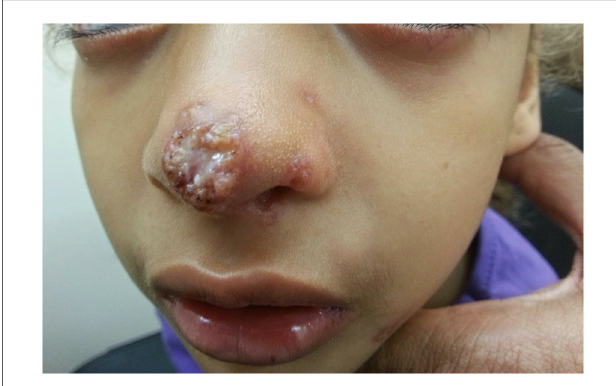
FIGURE 4 An erythematous plaque with a central erosion, circinate-elevated border, overlying pustules, and purulent discharge on the tip of the nose of a 10.5- year-old girl with AT. Small satellite papules were also present on the nostrils, consistent with a fungal infection. AT, ataxia